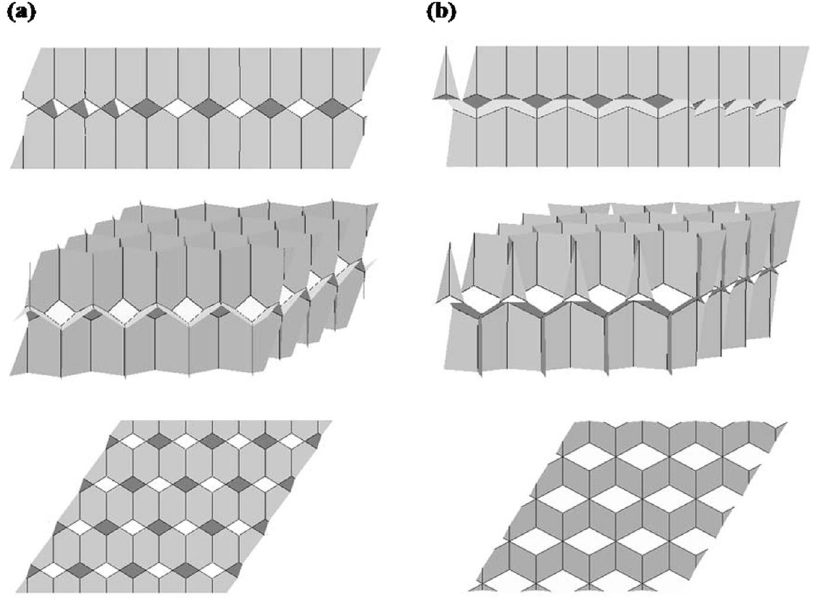
Figure 6. Surface Evolver simulations of two kinds of bilayer monodisperse systems for the dry foams: ( a ) Tóth structure. ( b ) Honeycomb structure. The upper-layer units of both these two structures are inverted above the lower-layer units. The white spots are not holes through the foam, but just a lighting effect on faces of a certain